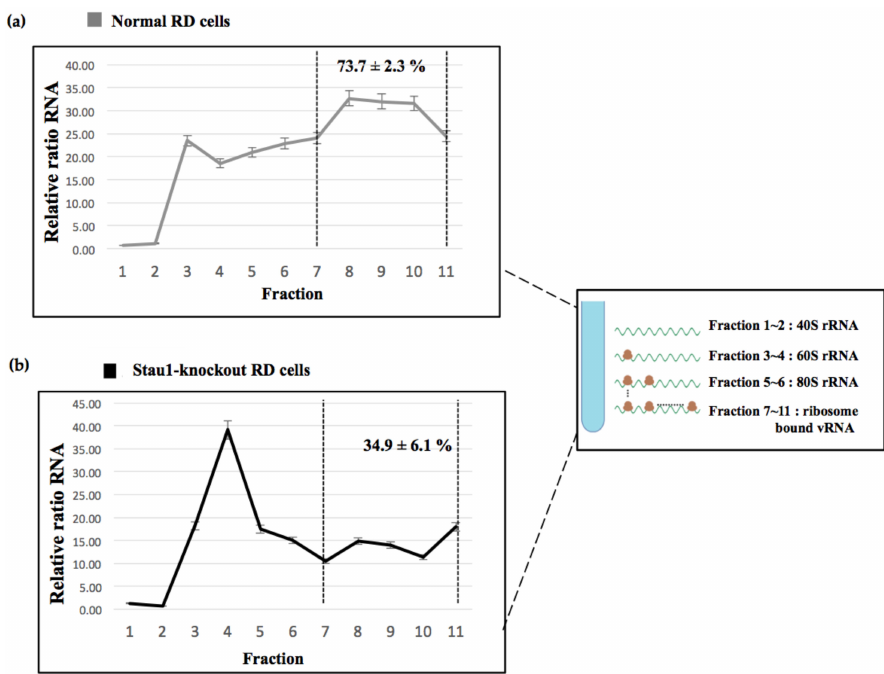
Figure 6. Investigation of polysome profile in the Stau1 knockout cells. The normal and Stau1 knockout RD cells were infected with EV17 at an MOI of 1. At 24 h postinfection, the cell lysates were harvested and subjected to sucrose density fractionation to obtain the polysome profile. Each fraction was harvested for RNA isolation and quantitation. ( a ) EV-A71-infected normal RD cells. ( b ) EV-A71-infected Stau1 knockout RD cells. The representative of different ribosomal RNAs and ribosome-bound mRNA (between two vertical dot lines) is shown in the enlarged panel (The wave line is referred to the different